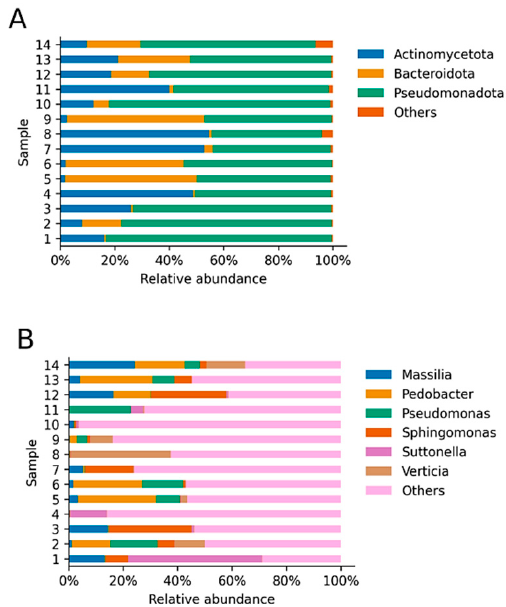
Figure 2. Relative abundance of taxa ( A ). Relative abundance of the most abundant identified phyla. Reads derived from both eyes were combined and phyla with an average relative abundance lower than 1% were labeled as “others”. The three plotted phyla represent 98.72% on average of the total relative abundance of all samples. ( B ). Relative abundance of the most abundant identified genera. Reads derived from both eyes were combined and genera with an average relative abundance lower than 5% were labeled as “others”. The six plotted genera represent 36.59% on average of the total relative abundance of each sample. The “other” genera represent 63.41% on average (Supplementary Table S1).